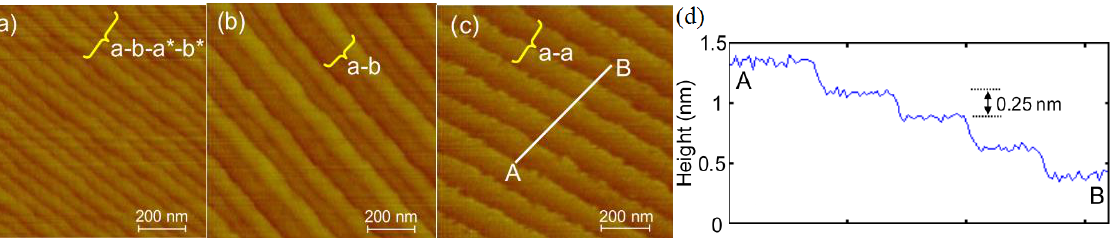
Figure 18. AFM images of the SiC surfaces processed by CeO 2 abrasives: ( a ) Rp < Ro, ( b ) Rp ≈ Ro, ( c ) Rp > Ro, ( d ) cross-sectional of AB in ( c ) [45] .